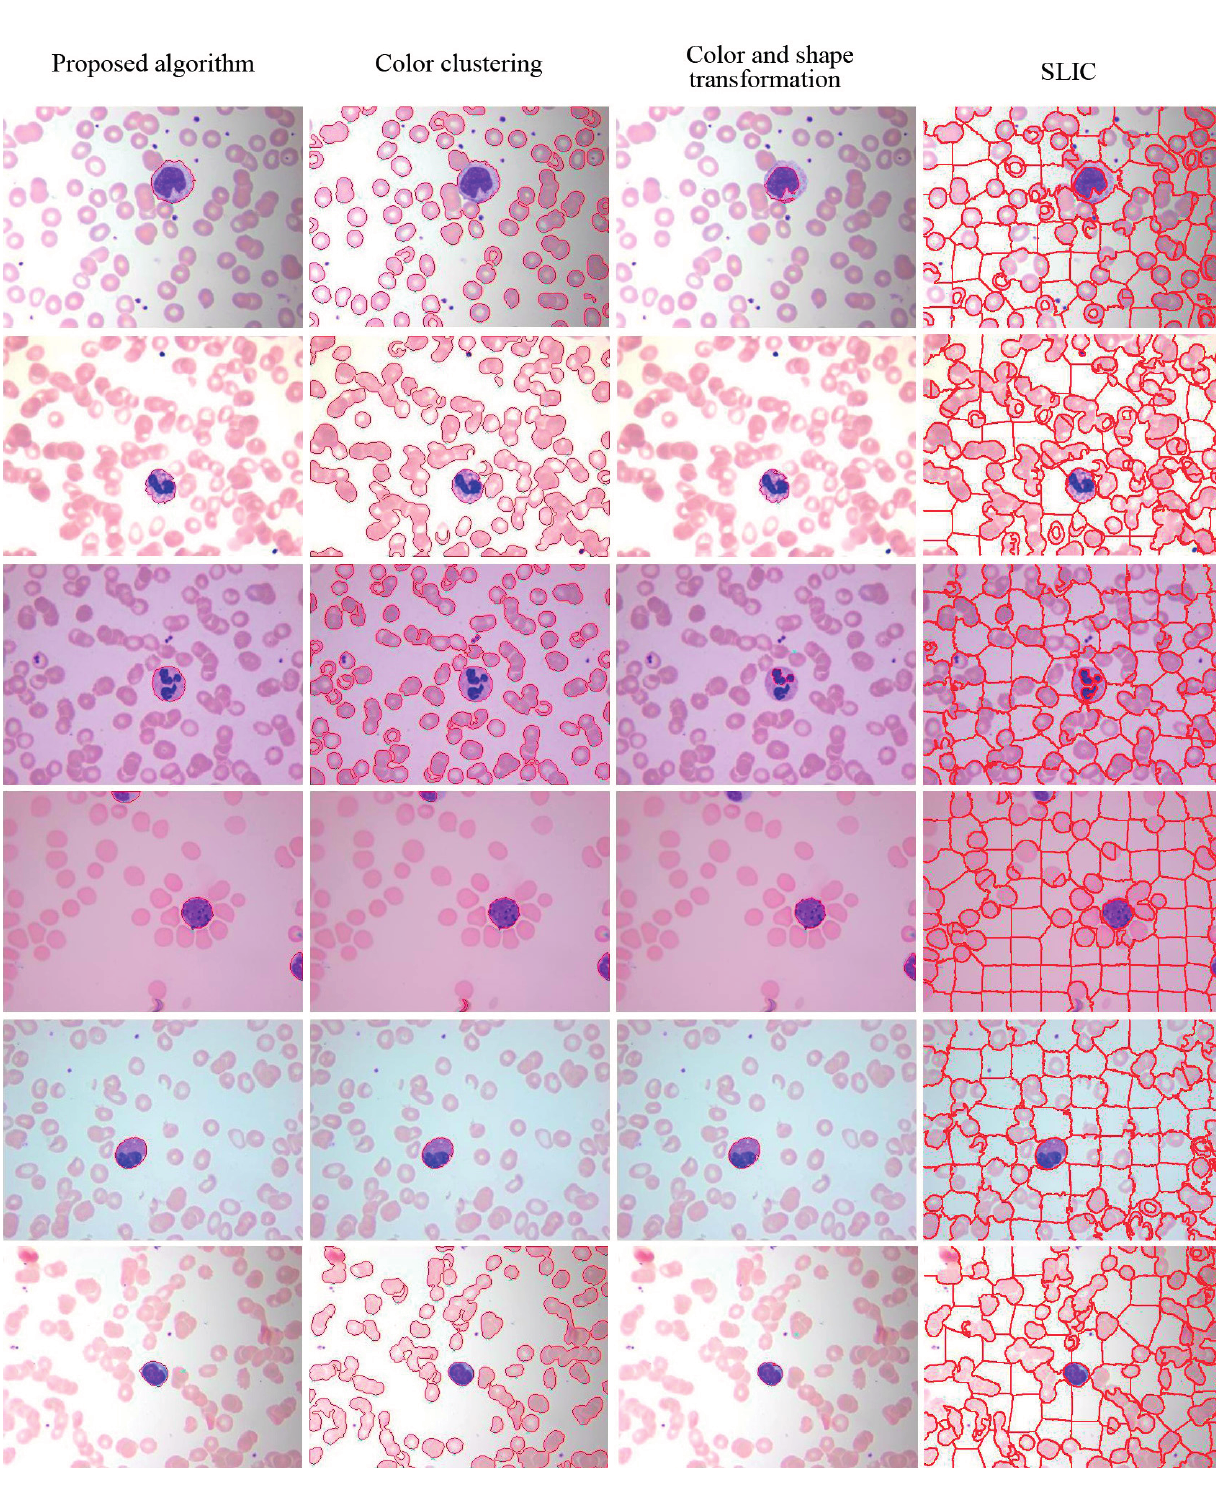
Figure 15. Peripheral blood images of (top to bottom) monocyte, staff neutrophil, segmented neutrophil, basophil, eosinophil, and lymphocyte (segmented WBCs marked with red